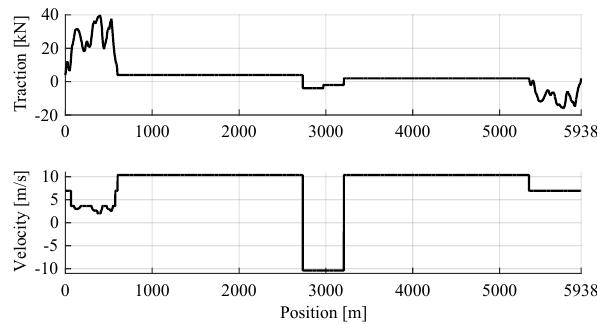
Figure 10: Driving cycle of a fictional dumper in a quarry, data from Rebholz et al.